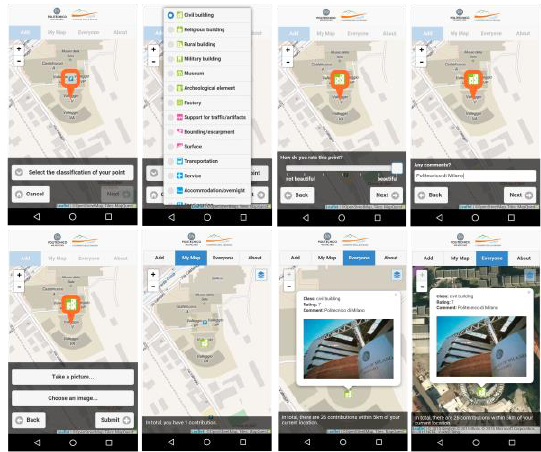
Figure 4. Submitting a point using the application